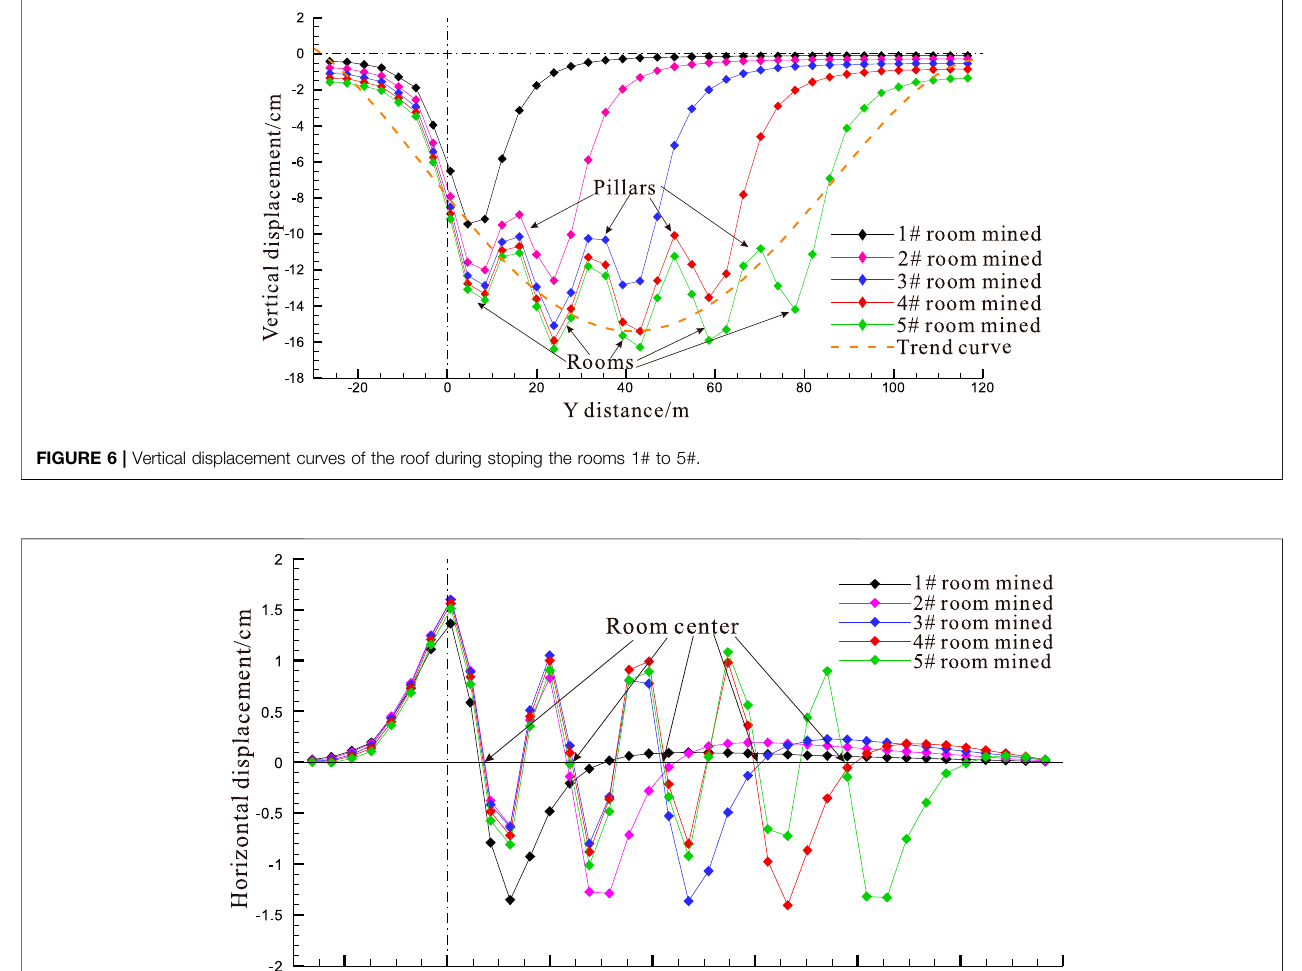
Frontiers in Earth Science |